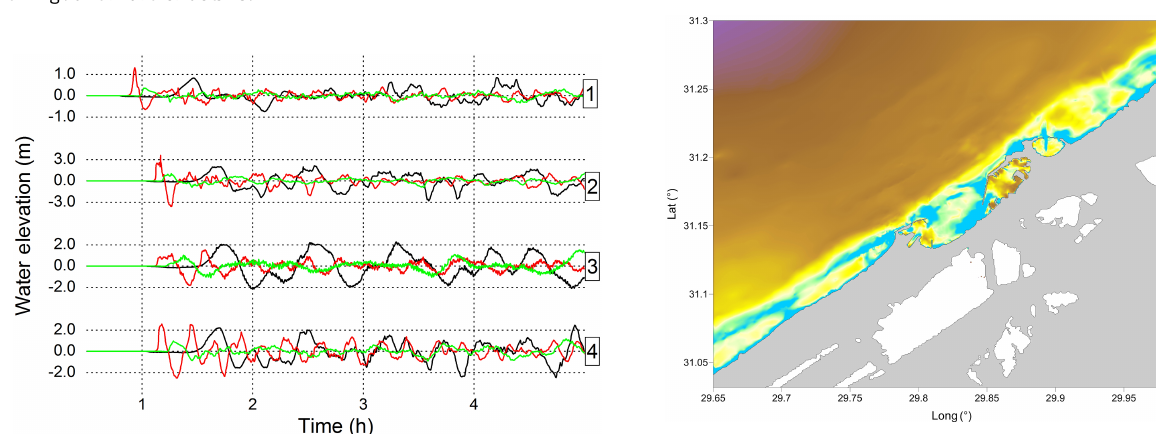
Figure 15. Time series calculated in the four positions shown in Fig. 6 for mean-sea-level conditions: the black line denotes the WHA tsunami, the red line the EHA tsunami and the green line the CA tsunami.